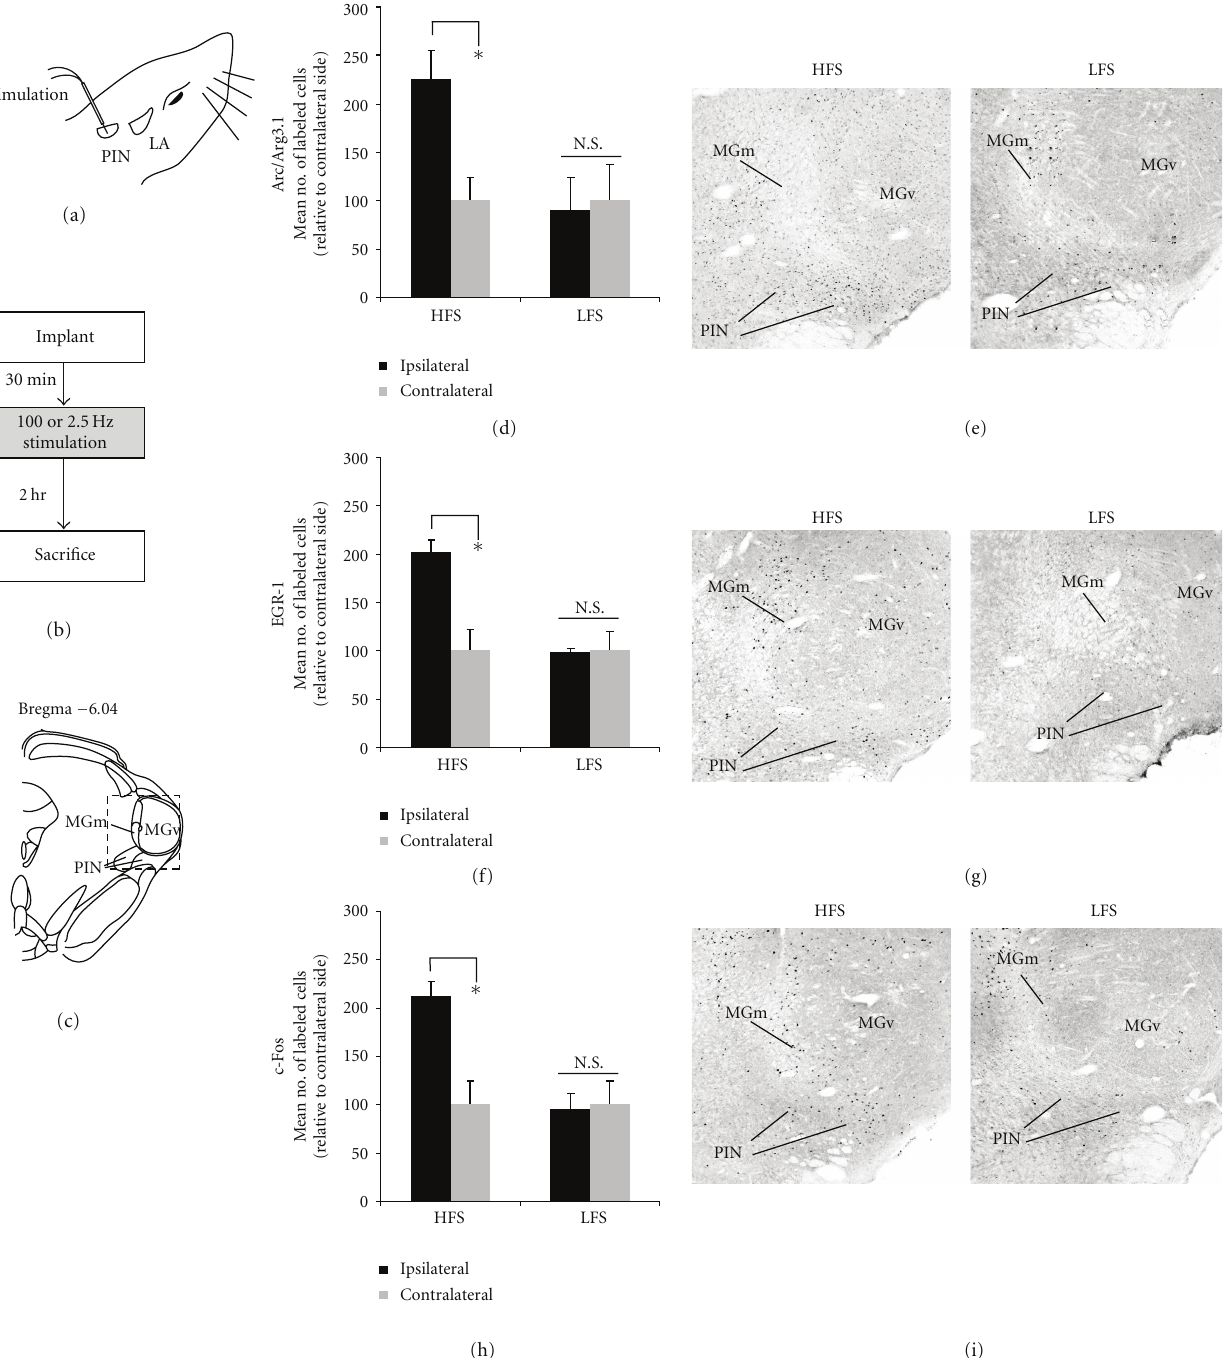
Figure 4: High-frequency stimulation of the MGm/PIN promotes increased immunolabeling of ERK-driven IEGs in the MGm/PIN. (a) Placement of stimulation electrode. (b) Schematic representation of experimental protocol. Rats were given HFS or LFS and sacrificed 2 hours after stimulation. (c) Schematic representation of the auditory thalamus at Bregma –5.6. (d) Mean ( ± SEM) percent Arc/Arg3.1 immunoreactive cells in the MGm/PIN from rats receiving HFS ( n = 6) or LFS ( n = 6). (e) Photomicrographs showing Arc/Arg3.1-labeled cells from rats receiving HFS (left) or LFS (right). (f) Mean ( ± SEM) percent EGR-1 immunoreactive cells in the MGm/PIN from rats receiving HFS ( n = 6) or LFS ( n = 6). (g) Photomicrographs showing EGR-1-labeled cells from rats receiving HFS (left) or LFS (right). (h) Mean ( ± SEM) percent c-Fos immunoreactive cells in the MGm/PIN from rats receiving HFS ( n = 6) or LFS ( n = 6). (i) Photomicrographs showing c-Fos-labeled cells from rats receiving HFS (left) or LFS (right). In each experiment, ipsilateral cell counts have been expressed as a percentage of contralateral cell counts for each rat. ∗ P < . 05 relative to the ipsilateral side N.S. = not significant. MGm = medial division of the medial geniculate nucleus; MGv = ventral division of the medial geniculate nucleus; PIN = posterior intralaminar